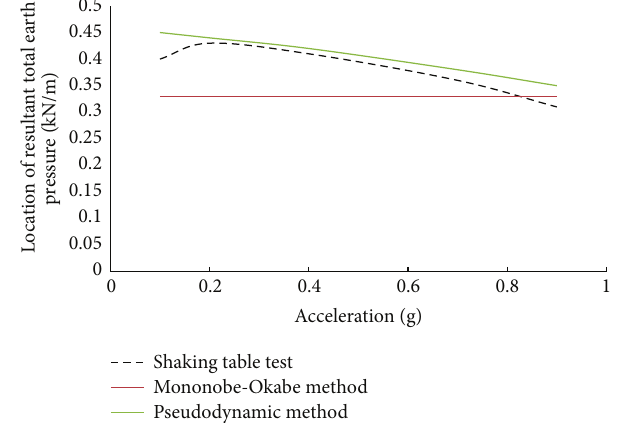
Figure 17: Comparisonoflocations of resultanttotal earth pressures ( h/H )andtheoreticalresultsbypseudostaticmethodandpseudody- namic method for rock